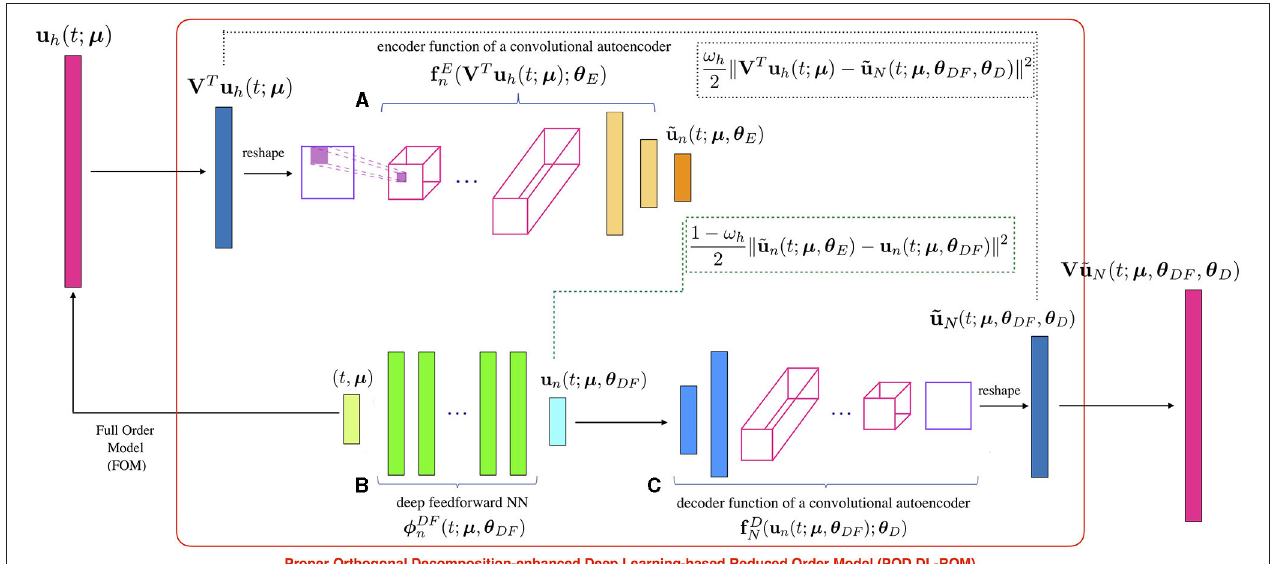
FIGURE 1 | Starting from the FOM solution u h ( t ; µ ), the intrinsic coordinates V T u h ( t ; µ ) are computed through rSVD; their approximation ˜ u N ( t ; µ ) is provided by the neural network as output, so that the reconstructed solution ˜ u h ( t ; µ ) is recovered through the rPOD basis matrix. In particular, the intrinsic coordinates V T u h ( t ; µ ) are provided as input to block (A) , which returns as output ˜ u n ( t ; µ ). The same parameter instance ( t ; µ ) enters block (B) , which provides as output u n ( t ; µ ), and the error between the low-dimensional vectors is accumulated. The minimal coordinates u n ( t ; µ ) are given as input to block (C) , which returns the approximated intrinsic coordinates ˜ u N ( t ; µ ). Then, the reconstruction error is computed.